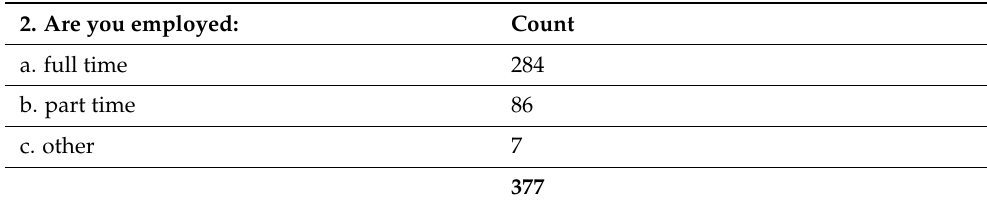
Figure A2. Part ‐ time or full ‐ time employees. 4. Do you consider that you performed the telework activity with the same efficiency as at the office?